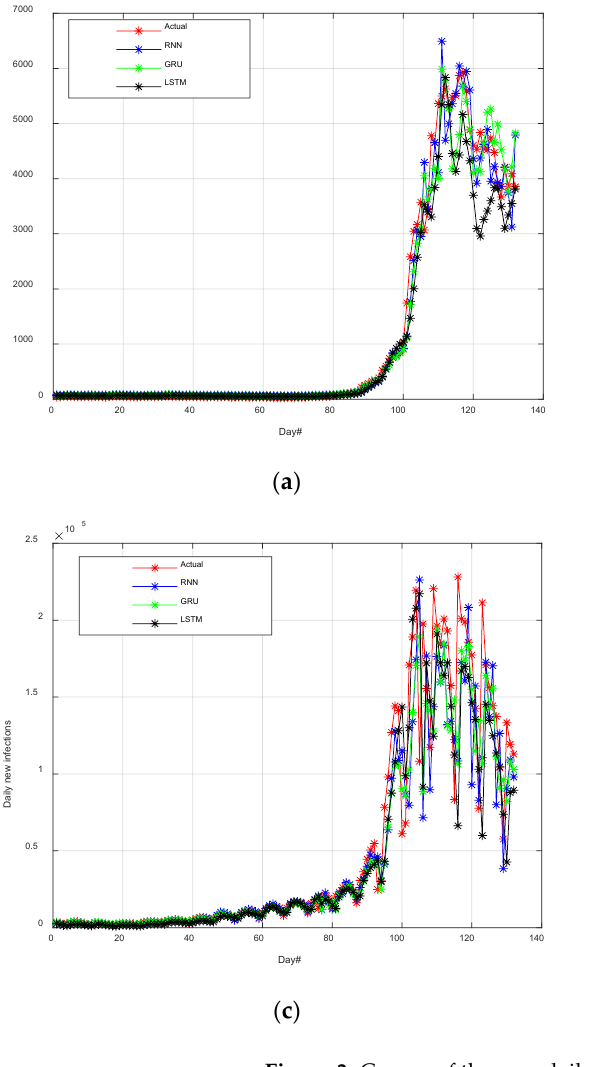
Table 5. Performance metrics of RNN, GRU, and LSTM DL algorithms during the testing period (Italy and India).